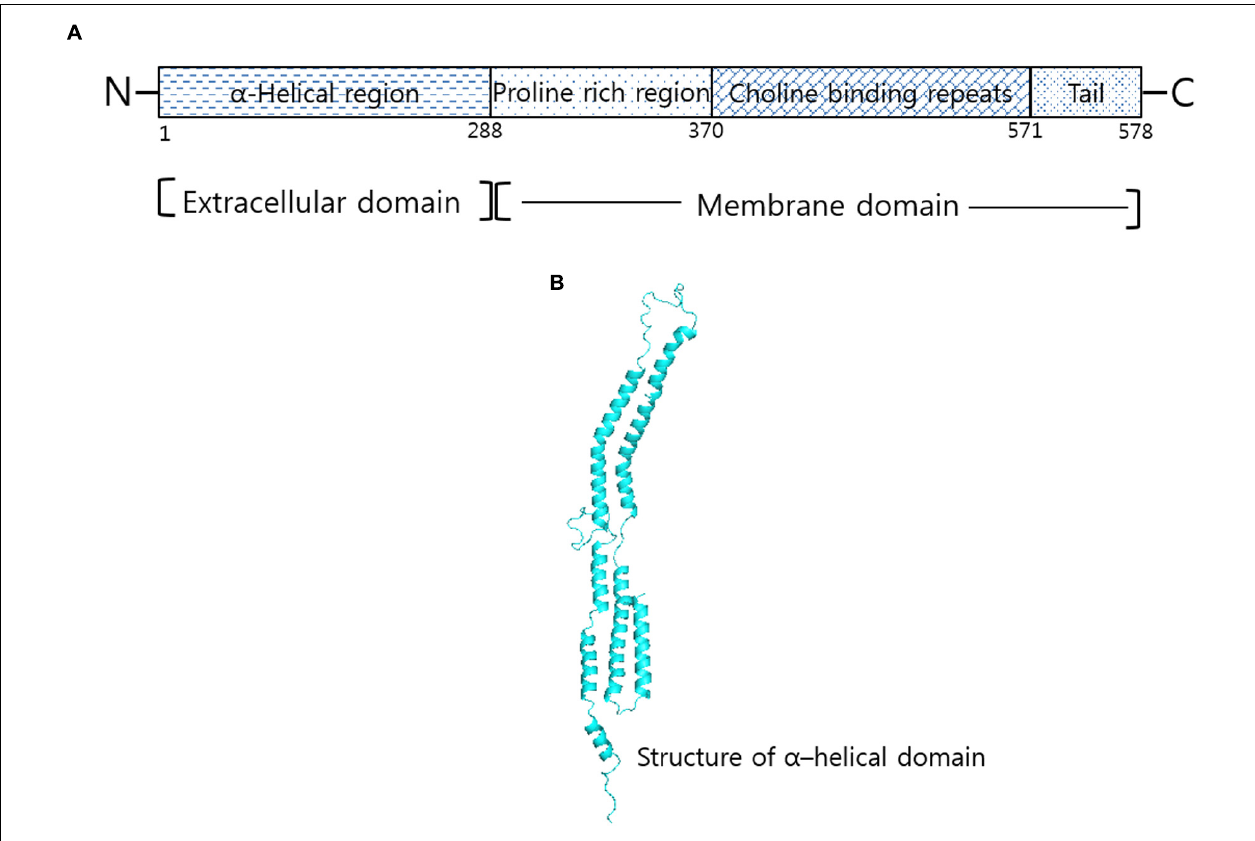
FIGURE 1 | Structural correlation of PspA in Streptococcus pneumoniae . (A) Domain organization of PspA in R36A strain show α -helical region, proline rich and choline binding repeat regions. (B) Structure corresponding to α -helical domain of PspA generated by Swiss modeler online server (https://swissmodel.expasy.org/) and validated using Ramachandran plot of Rampage server tool